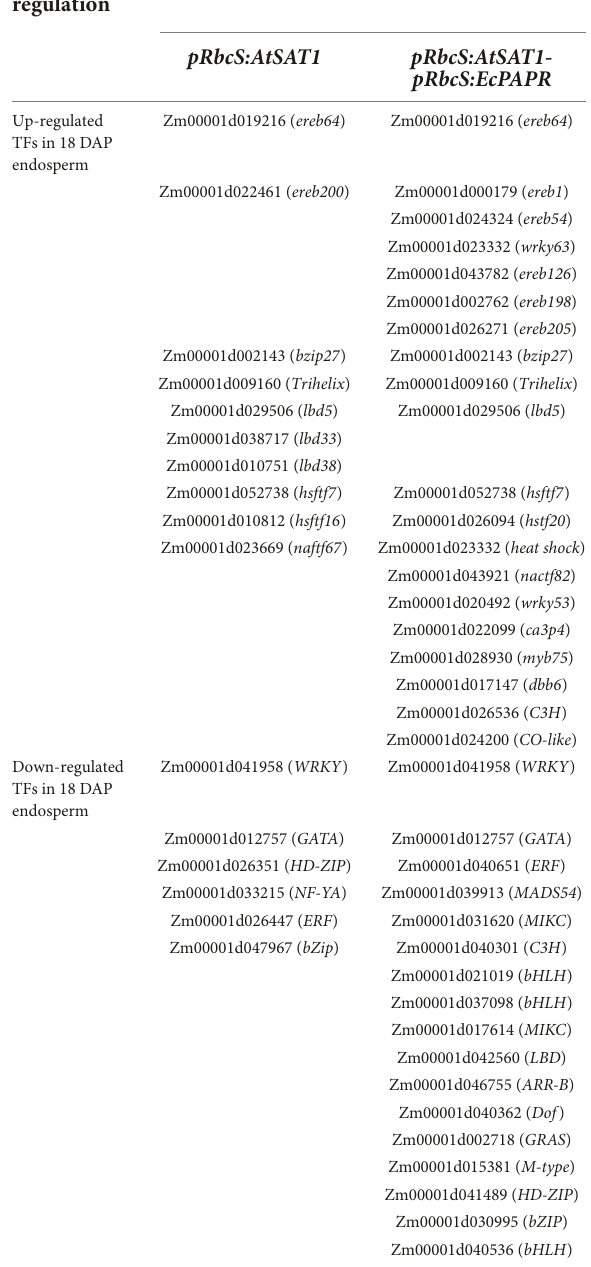
TABLE 3 TFs up regulated in 18 DAP endosperm of pRbcS:AtSAT1 and